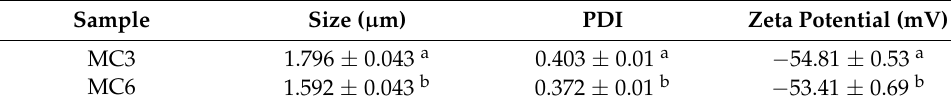
Table 2. Particle size, poly-dispersity index (PDI), and zeta potential of spray-dried microcapsules loaded with SO-TSO having MBPI and SA as wall